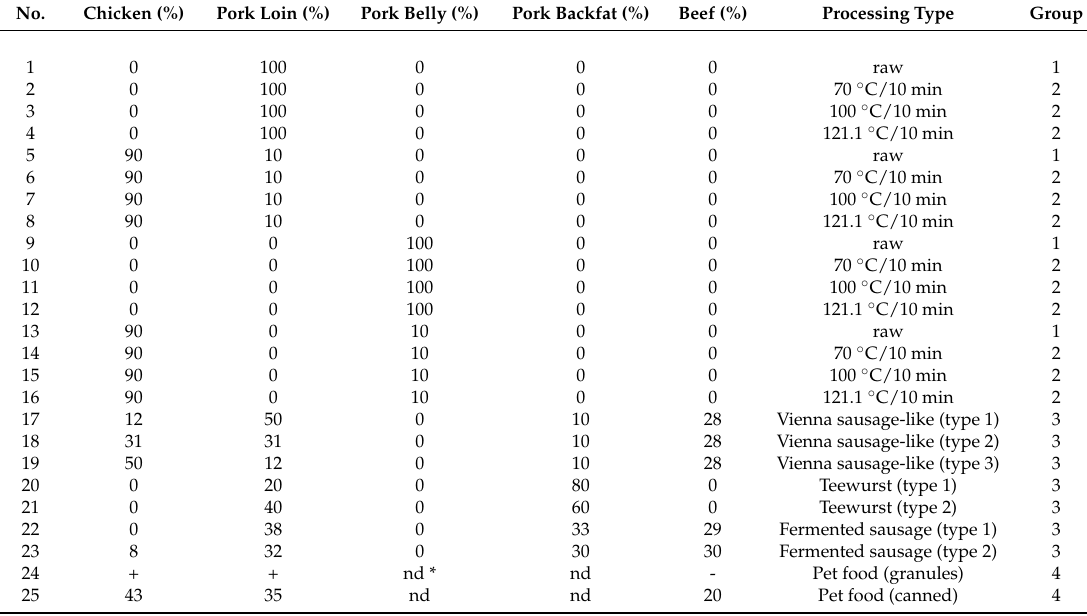
Table 3. Samples tested in the